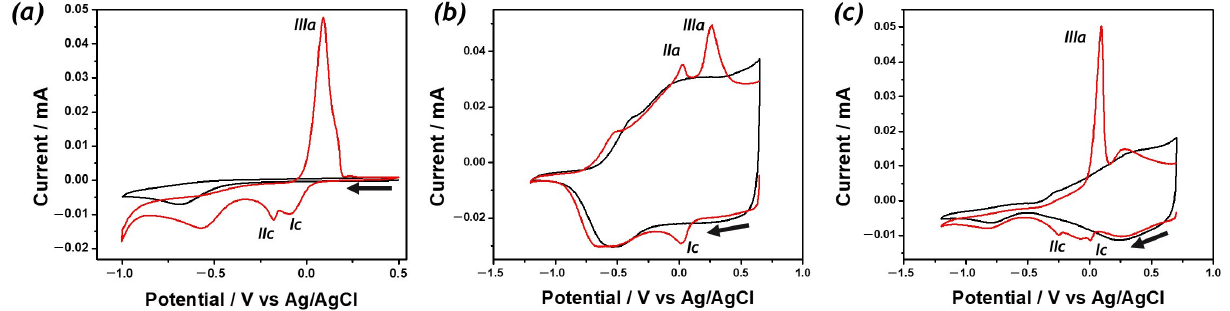
Figure 1. Potentiodynamic reduction of a 0.1 M LiClO 4 , acetate buffer (pH 4) aqueous solution with 100 ppm Cu 2+ (red line) and without Cu 2+ (black line) using ( a ) GC, ( b ) PEDOT, and ( c ) PXDOT electrodes.